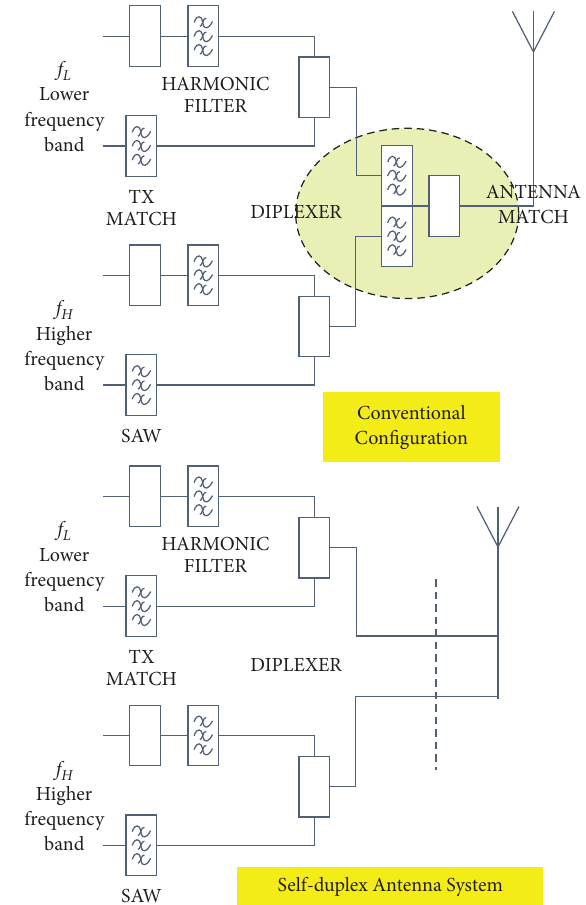
Figure 1: Architecture of self-duplex antenna